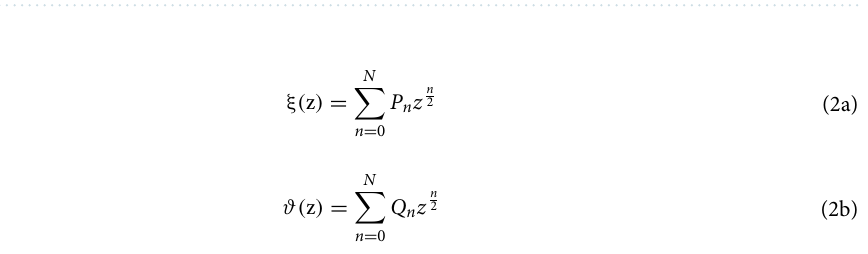
Figure 2. Elastomeric seals with various cross-sectional profiles; ( a ) O-ring ( b ) X-ring ( c ) square ring ( d )